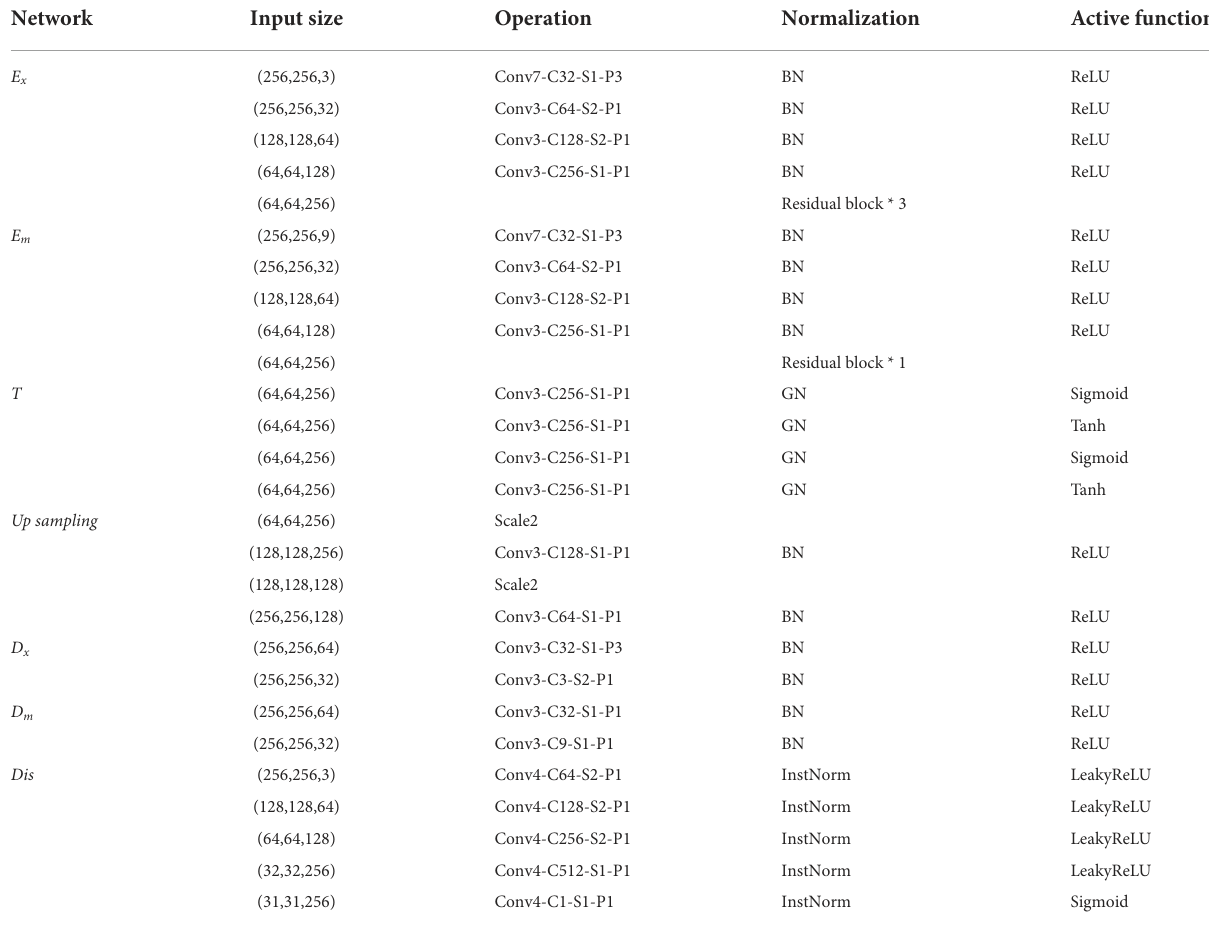
TABLE 2 The architectural details adopted in our model. Network Input